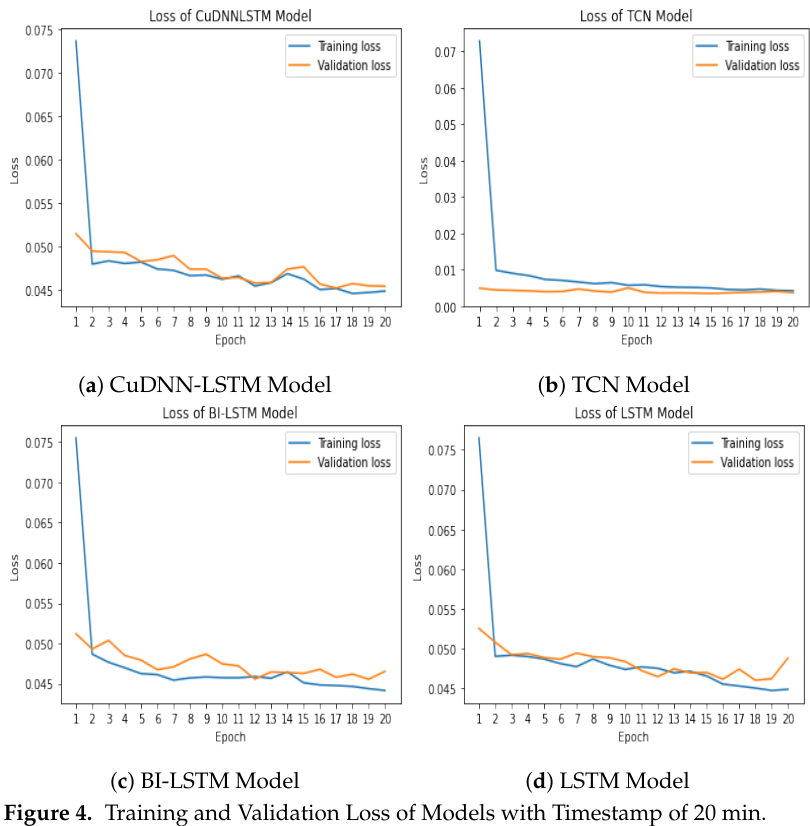
Figure 4. Training and Validation Loss of Models with Timestamp of 20